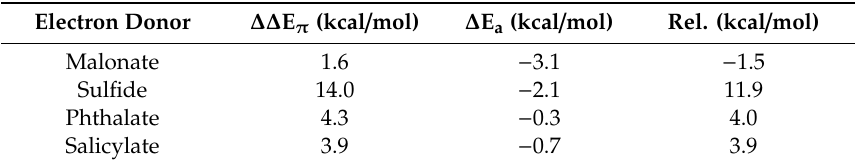
Table 6. Di ff erences between re and si enantiofaces of π -complexation energies ( ∆∆ E π ), intrinsic activation energies ( ∆ E a ), and transition state energies of the primary (1,2) insertion step (relative barrier,